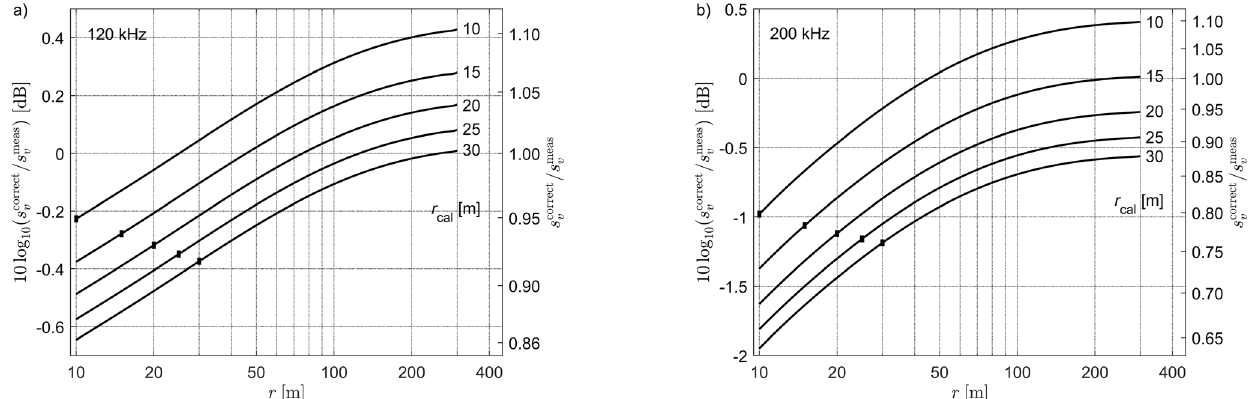
Figure 4. Numerically calculated example values for the fi nite-amplitude correction factor s correct v = s meas v , with sound propagation parameters from Table 1 and 1000 W power setting for both calibration at range r cal and s v measurement at range r . The calibration range is indicated with a mark on each curve. Logarithmic scale, with corresponding ratios shown on the right-hand ordinate axis. (a) 120 kHz, (b) 200 kHz.